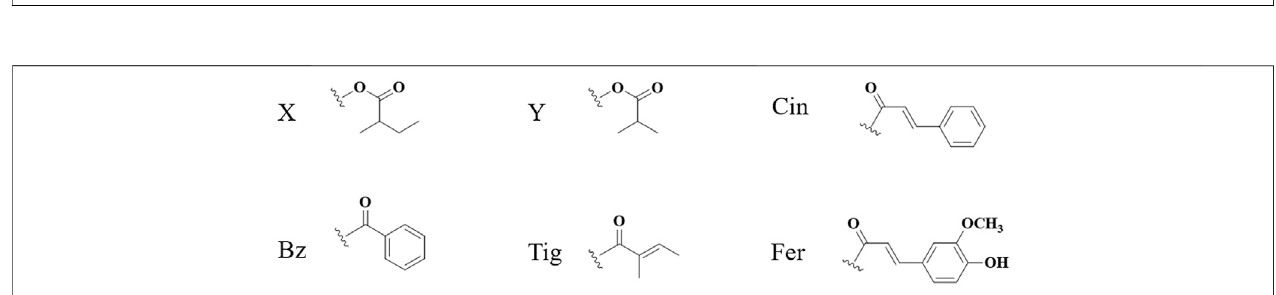
FIGURE 6 | Structures of meliacarpin class limonoids 203 – 208 (A) and structures of other-class limonoids 209 – 214 (B) . Rha, rhamnose; Glc, clucose; Ara, arabinose.